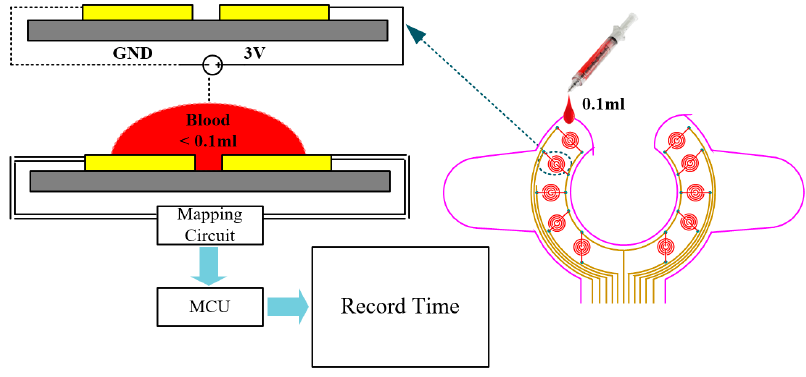
Figure 9 . Schematic diagram of the multi-channel sensing experiment.